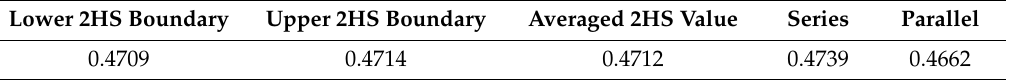
Table 11. Two-phase thermal conductivity approximations—cement system D. Lower 2HS Boundary Upper 2HS Boundary Averaged 2HS Value